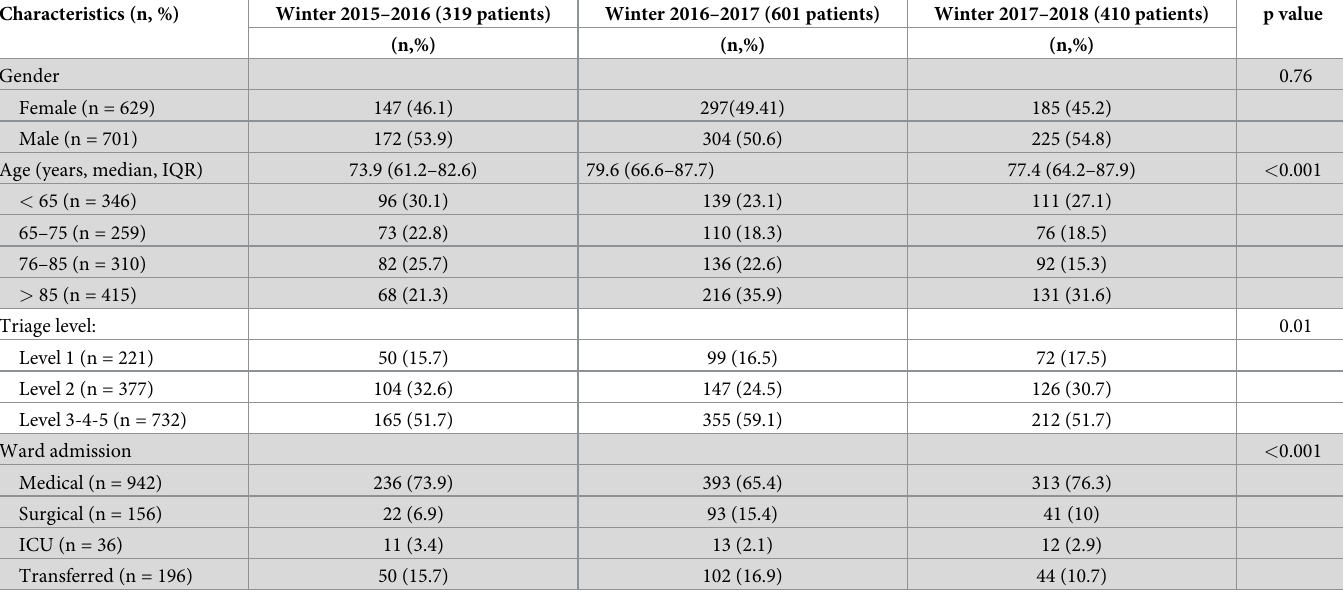
Table 1. Characteristics of included patients with ILI, during the three winter epidemics (2015–2018) at Bichat Claude Bernard Hospital. Characteristics (n, %)